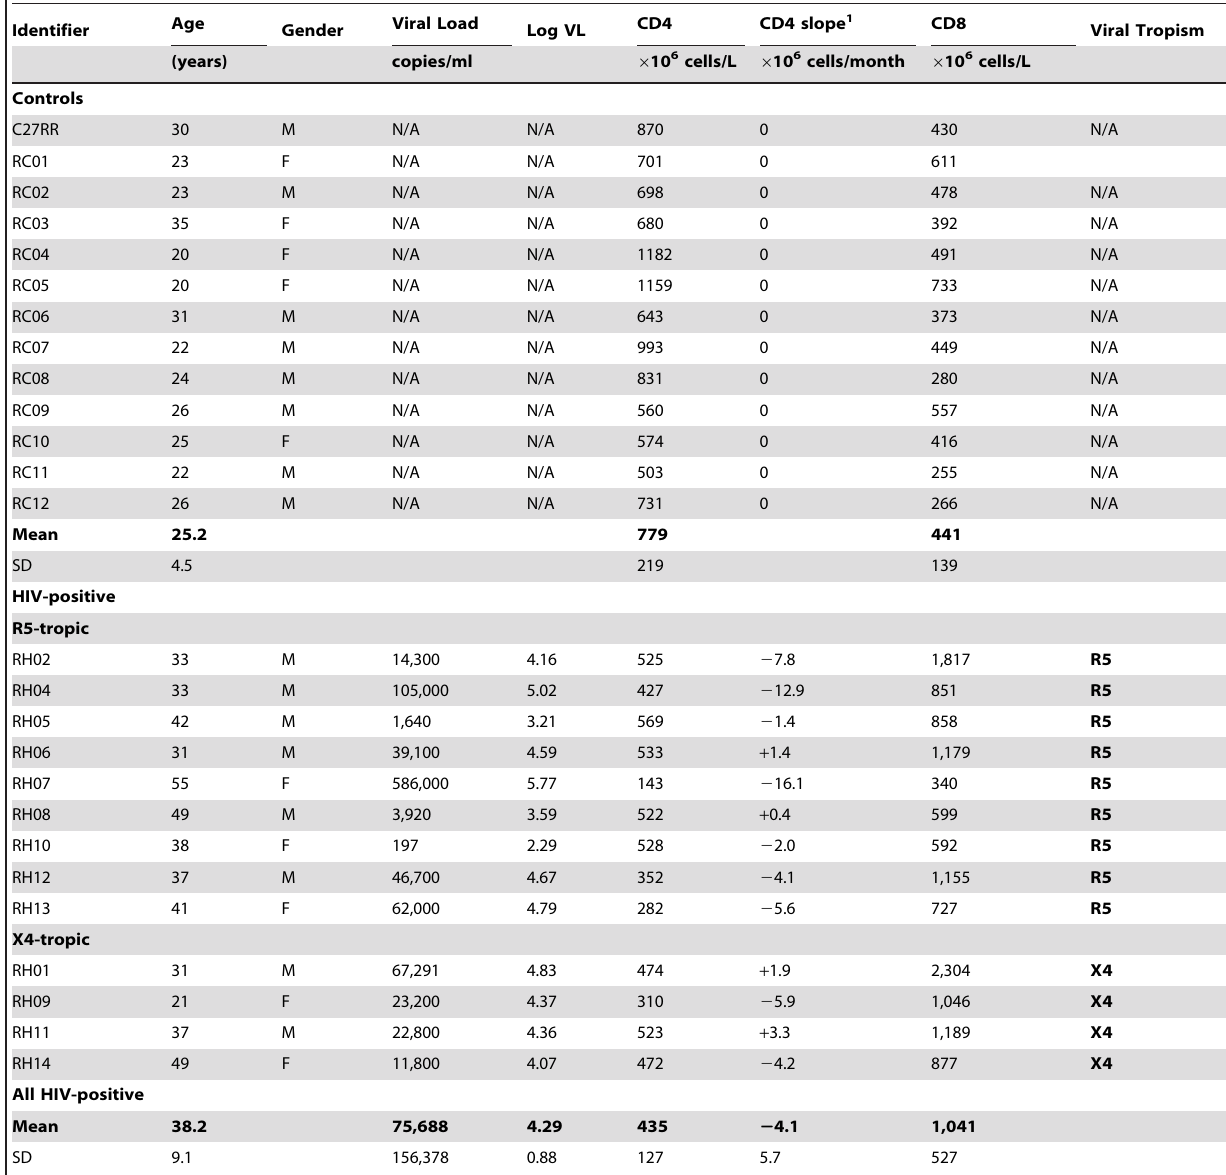
Table 1. Subject